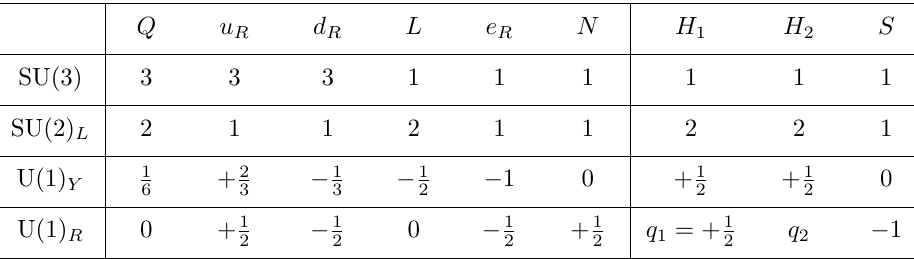
Table 1 . Matter contents and charge assignment of the